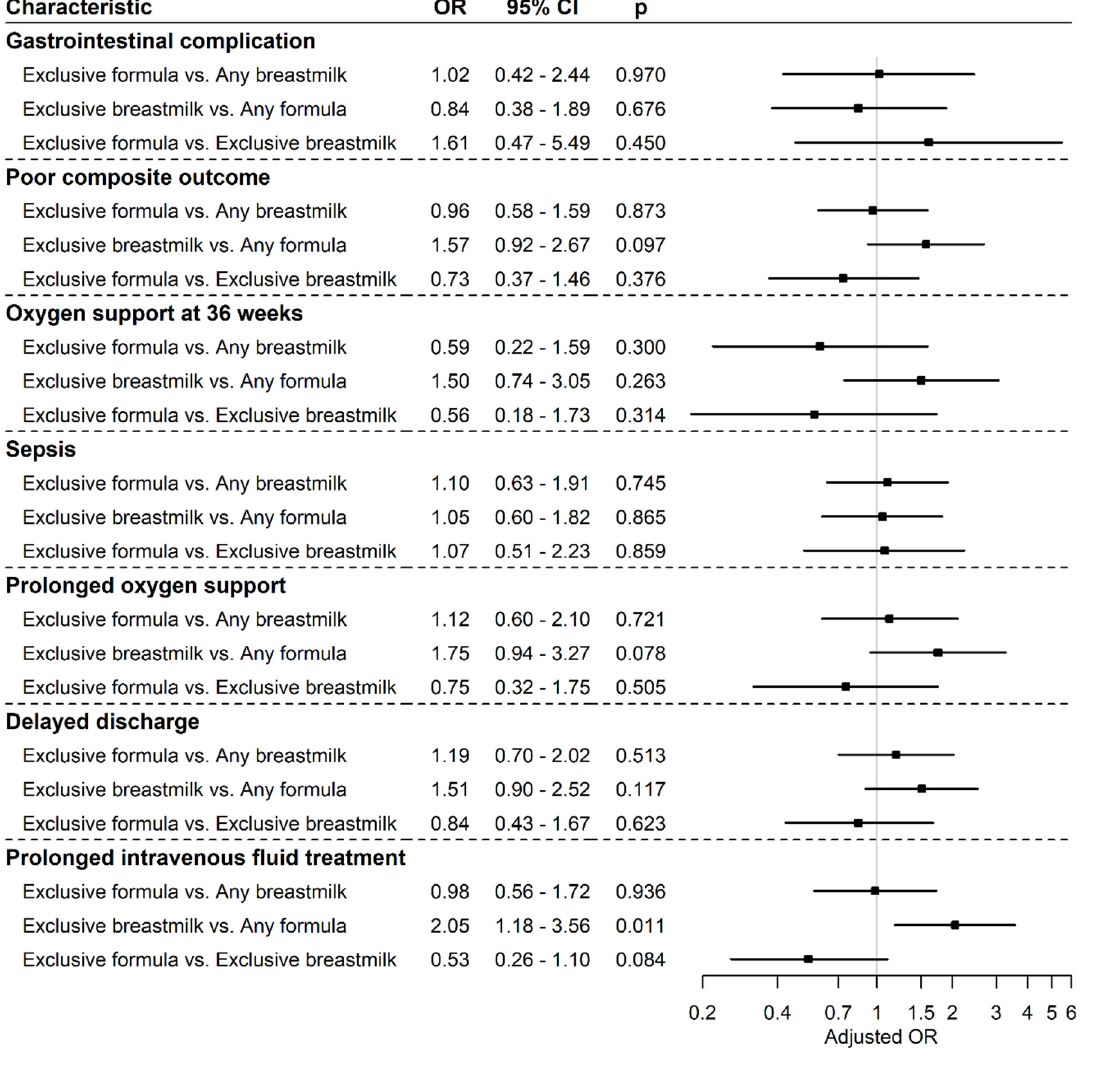
Figure 2. Multivariate analysis, forest plot. (Israel, Figure 2. multivariate analysis, forest plot. (Israel, 2012–2017).